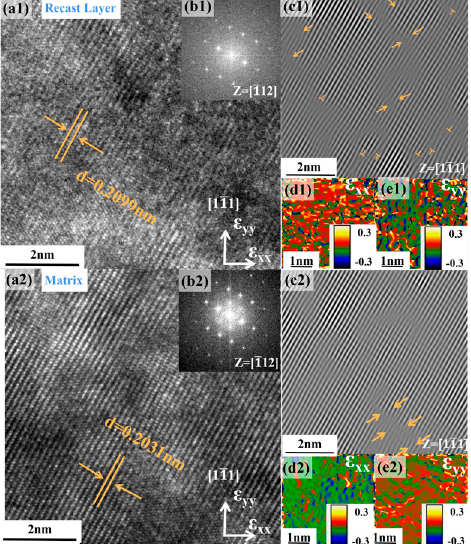
Figure 5. High-resolution transmission electron microscopy analyses of the recast layer ( a1 – e1 ) and